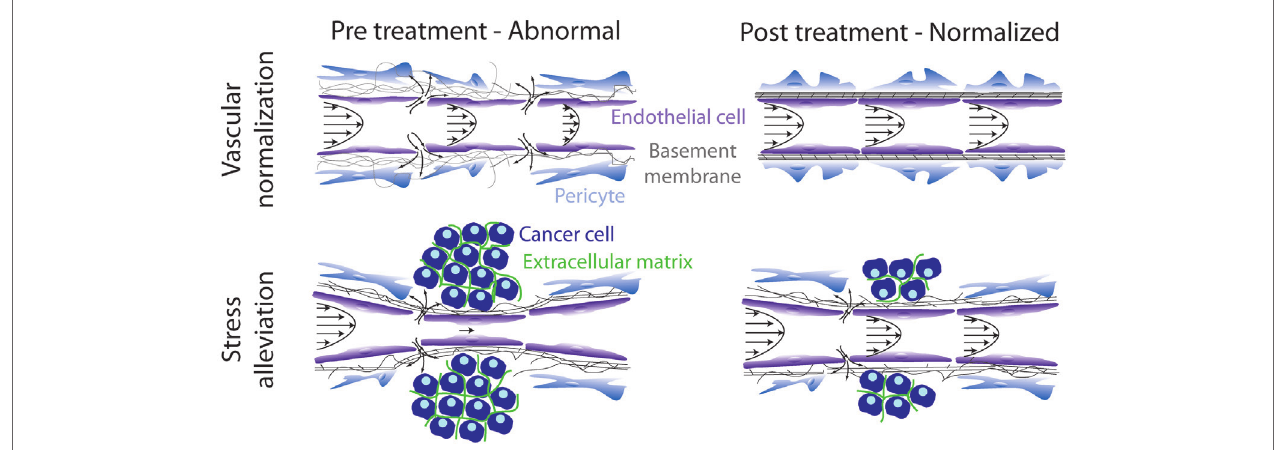
FiGURe 1 | Schematic of strategies to remodel the tumor microenvironment to enhance cancer therapy . Vascular normalization treatment fortifies the hyperpermeable tumor blood vessels, whereas stress alleviation reopens compressed tumor blood vessels. Both strategies aim at improving tumor perfusion. Adapted with permission from Ref.